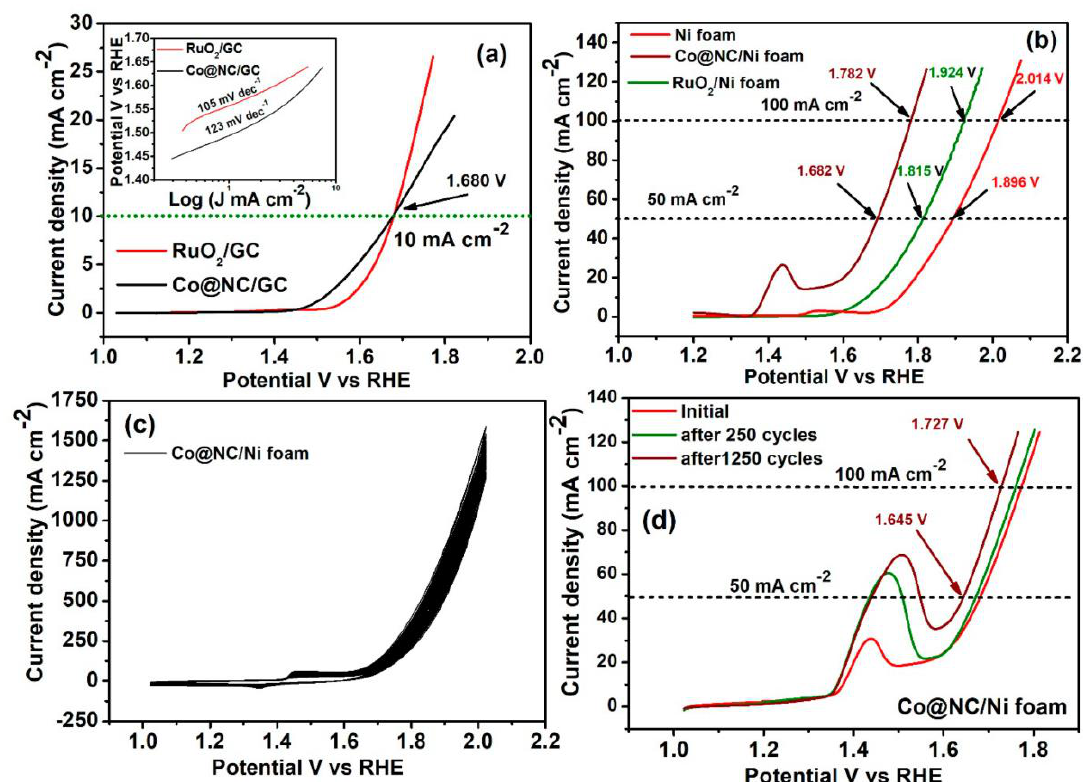
Figure 6. OER LSVs measured at 5 mV · s − 1 in 1.0 M KOH solution of Co@NC and commercial RuO 2 catalysts in ( a ) glassy carbon electrode ( b ) Ni foam. the corresponding Tafel plots derived from data of ( a ) given in the inset of figure ( a ). ( c ) cyclic voltammograms of the Co@NC/Ni foam catalyst ( d ) LSVs recorded before and after 250 and 1250 cycles using Co@NC/Ni foam catalyst.